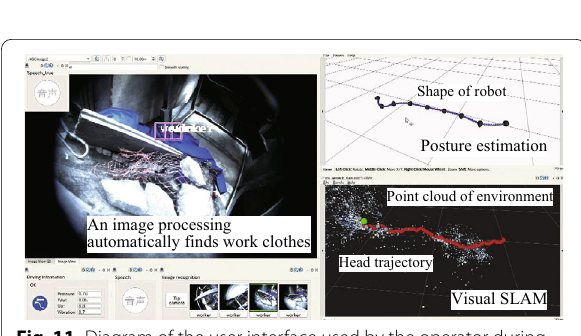
Fig. 11 Diagram of the user interface used by the operator during operation. In the upper left corner, the camera image or the camera image when an object is found can be seen. In this figure, the camera image when the work clothes are found using the elemental technology is shown. The automatically recognized camera image is shown in the bottom center of the figure and can be viewed when needed. The upper right corner shows the estimated robot shape, and the lower right corner shows the estimated 3D map and the movement trajectory of the robot